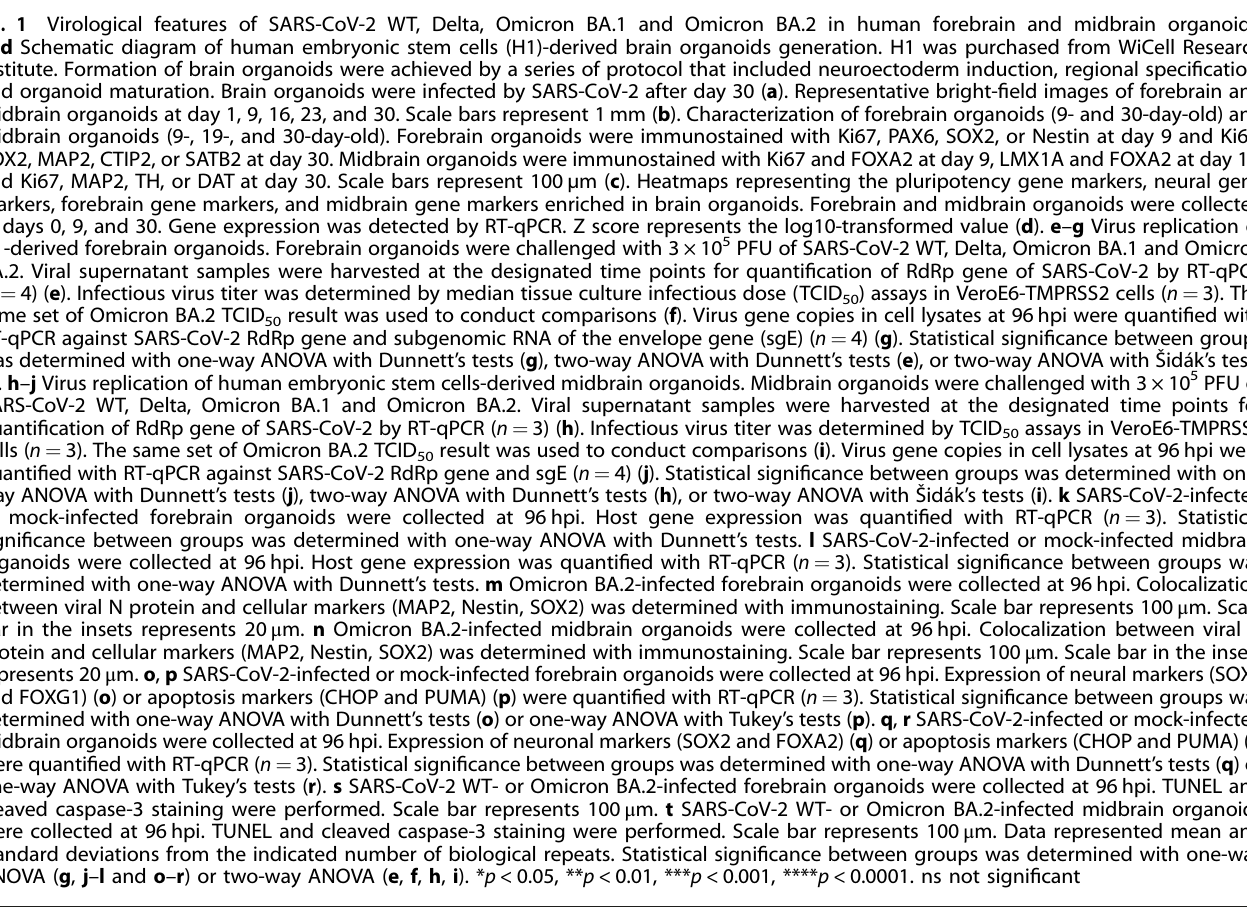
Fig. 1 Virological features of SARS-CoV-2 WT, Delta, Omicron BA.1 and Omicron BA.2 in human forebrain and midbrain organoids. a – d Schematic diagram of human embryonic stem cells (H1)-derived brain organoids generation. H1 was purchased from WiCell Research Institute. Formation of brain organoids were achieved by a series of protocol that included neuroectoderm induction, regional speci fi cation, and organoid maturation. Brain organoids were infected by SARS-CoV-2 after day 30 ( a ). Representative bright- fi eld images of forebrain and midbrain organoids at day 1, 9, 16, 23, and 30. Scale bars represent 1 mm ( b ). Characterization of forebrain organoids (9- and 30-day-old) and midbrain organoids (9-, 19-, and 30-day-old). Forebrain organoids were immunostained with Ki67, PAX6, SOX2, or Nestin at day 9 and Ki67, SOX2, MAP2, CTIP2, or SATB2 at day 30. Midbrain organoids were immunostained with Ki67 and FOXA2 at day 9, LMX1A and FOXA2 at day 19, and Ki67, MAP2, TH, or DAT at day 30. Scale bars represent 100 µm ( c ). Heatmaps representing the pluripotency gene markers, neural gene markers, forebrain gene markers, and midbrain gene markers enriched in brain organoids. Forebrain and midbrain organoids were collected at days 0, 9, and 30. Gene expression was detected by RT-qPCR. Z score represents the log10-transformed value ( d ). e – g Virus replication of H1-derived forebrain organoids. Forebrain organoids were challenged with 3 × 10 5 PFU of SARS-CoV-2 WT, Delta, Omicron BA.1 and Omicron BA.2. Viral supernatant samples were harvested at the designated time points for quanti fi cation of RdRp gene of SARS-CoV-2 by RT-qPCR RT-qPCR against SARS-CoV-2 RdRp gene and subgenomic RNA of the envelope gene (sgE) ( n = 4) ( g ). Statistical signi fi cance between groups was determined with one-way ANOVA with Dunnett ’ s tests ( g ), two-way ANOVA with Dunnett ’ s tests ( e ), or two-way ANOVA with Š idák ’ s tests ( f ). h – j Virus replication of human embryonic stem cells-derived midbrain organoids. Midbrain organoids were challenged with 3 × 10 5 PFU of SARS-CoV-2 WT, Delta, Omicron BA.1 and Omicron BA.2. Viral supernatant samples were harvested at the designated time points for quanti fi cation of RdRp gene of SARS-CoV-2 by RT-qPCR ( n = 3) ( h ). Infectious virus titer was determined by TCID 50 assays in VeroE6-TMPRSS2 cells ( n = 3). The same set of Omicron BA.2 TCID 50 result was used to conduct comparisons ( i ). Virus gene copies in cell lysates at 96 hpi were quanti fi ed with RT-qPCR against SARS-CoV-2 RdRp gene and sgE ( n = 4) ( j ). Statistical signi fi cance between groups was determined with one- way ANOVA with Dunnett ’ s tests ( j ), two-way ANOVA with Dunnett ’ s tests ( h ), or two-way ANOVA with Š idák ’ s tests ( i ). k